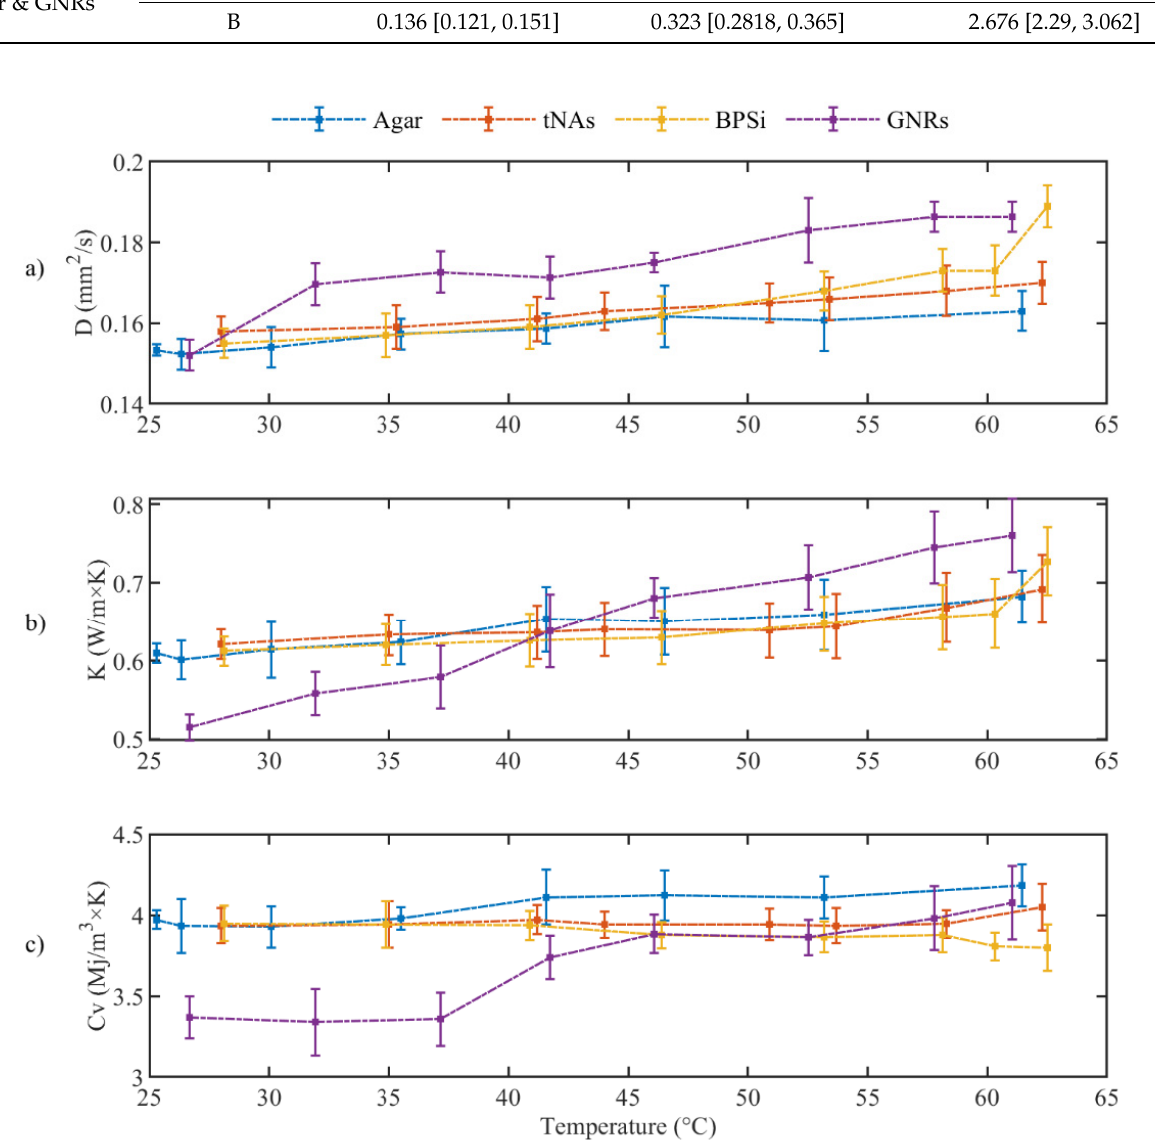
Figure 5. ( a ) Thermal diffusivity, ( b ) Thermal Conductivity and ( c ) Volumetric heat capacity for tissue mimicking phantom during the heating (p-value < 0.05).